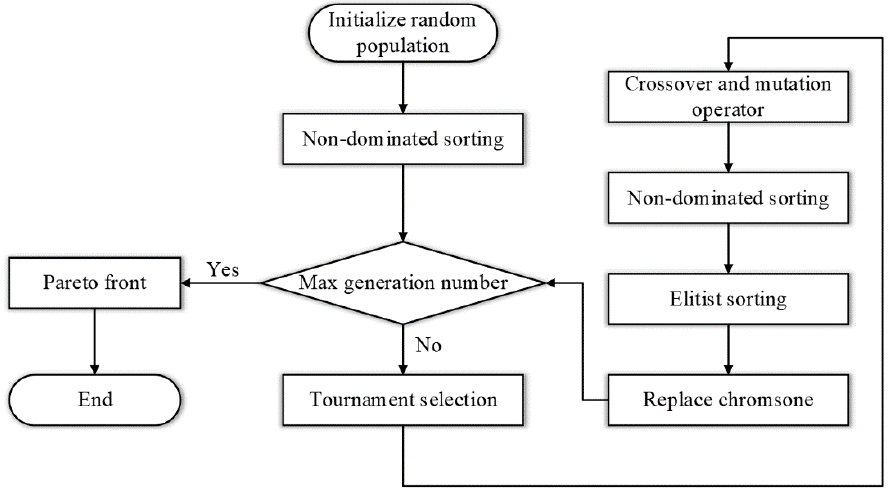
Figure 12. Flow chart of the NSGA ‐ II.